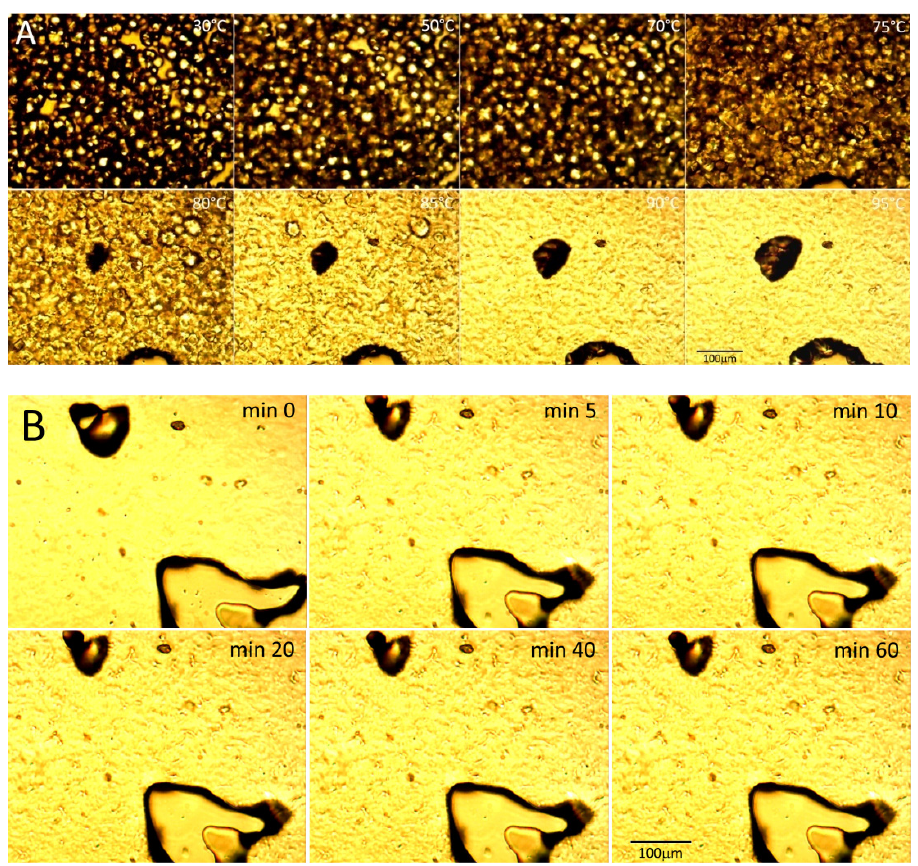
Figure 2. ( A ) Starch gelatinization: OM images of starch granules at temperatures ranging from 30 ◦ C to 95 ◦ C. ( B ) Starch retrogradation: OM images of starch granules at 40 ◦ C over